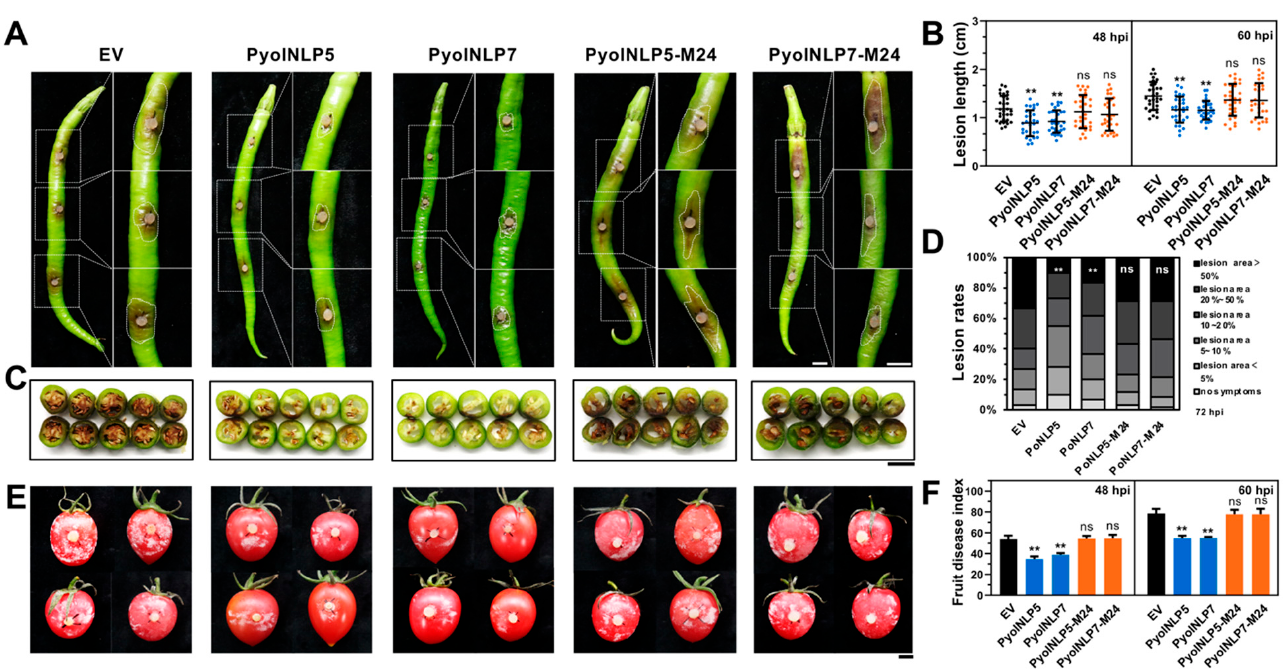
Figure 7. The nlp24 region is required for PyolNLP5- and PyolNLP7-mediated suppression of Phytophthora pathogen infection in pepper and tomato fruits. ( A ) Phenotypes of pepper fruits sprayed with 6 µ M PyolNLP5, PyolNLP7, PyolNLP5-M24 or PyolNLP7-M24 proteins and followed by P. capsici inoculation. Representative photos were taken at 60 hpi. ( B ) Lesions of pepper fruits inoculated with P. capsici at 48 and 60 hpi. Data were analyzed from 40 biological repeats. ( C ) Transection shows the disease severity of pepper fruit rot caused by P. capsici . ( D ) Ratings of pepper fruit rot caused by P. capsici . The disease symptoms were recorded at 72 dpi. Disease ratings are shown in different colors. ( E ) Phenotypes of tomato fruits sprayed with 6 µ M PyolNLP5, PyolNLP7 or their mutant proteins, and followed by P. capsici inoculation. Representative photos were taken at 60 hpi. ( F ) The fruit disease index of tomato fruit rot caused by P. capsici . The disease symptoms were recorded at 60 dpi. Bar = 1 cm. Data were analyzed from 40 biological repeats. Error bars represent the mean ± s.d. The data were analyzed by a median-edition Levene’s test to determine the homogeneity of variances across groups, and then analyzed by one-way ANOVA with a post hoc Tukey’s range test for groups with equal variances, or Kruskal–Wallis test analysis for groups with unequal variance; **, p < 0.01; ns, no significant differences. Experiments were repeated three times with similar